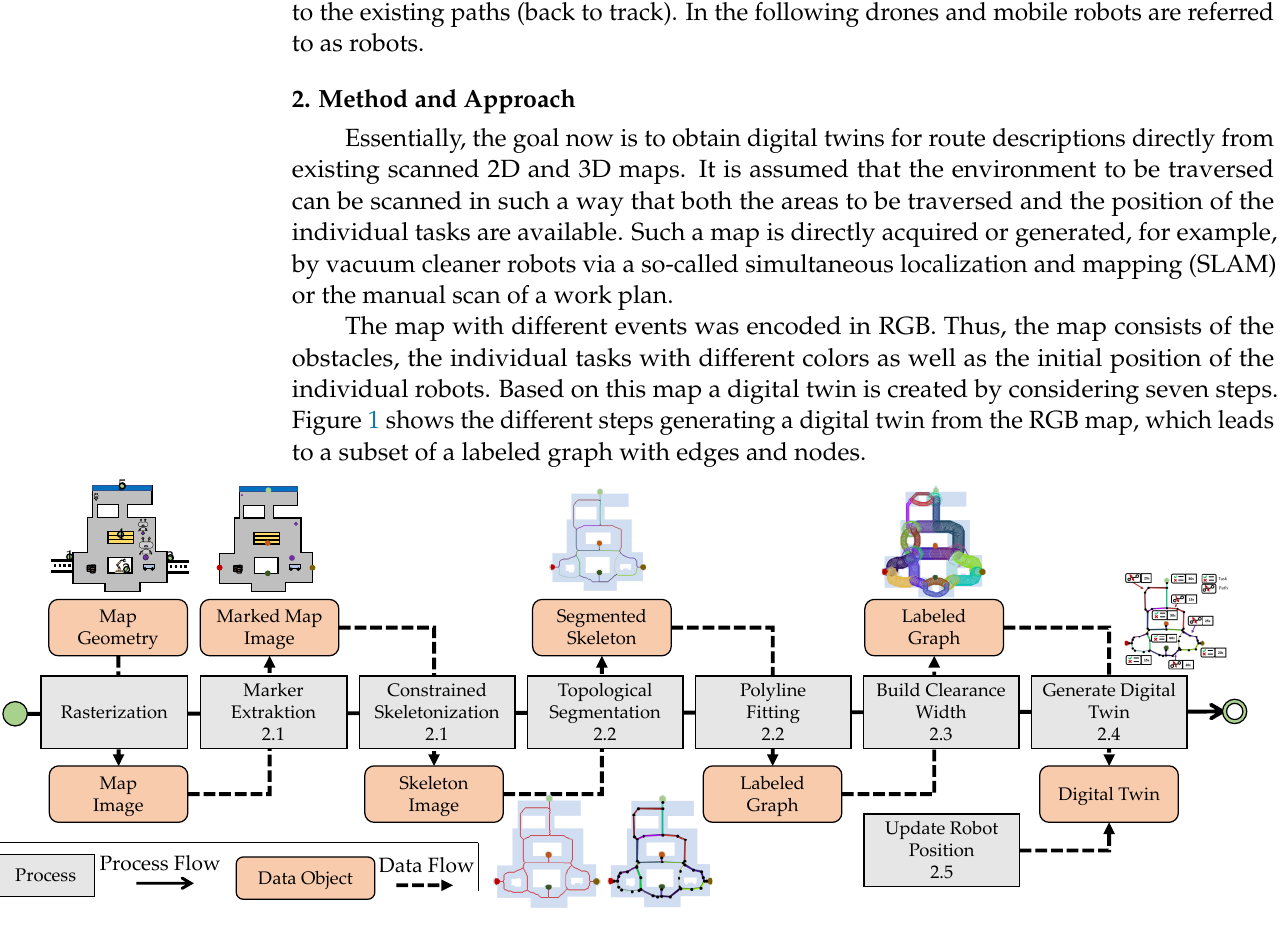
Figure 1. Digital twin generation: marker extraction and conditional shrinkage in 2.1, topological segmentation and polyline fitting in 2.2, clearance width estimation in 2.3, digital twin generation in 2.4, and robot position updating in 2.5.